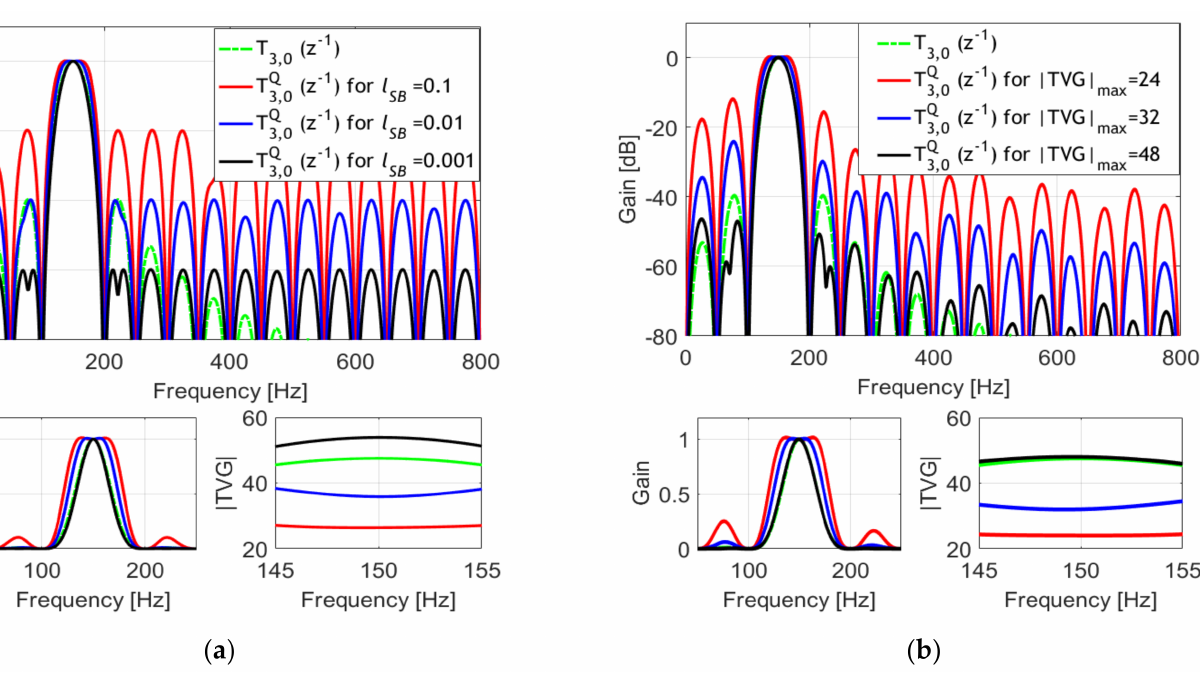
(cid:0) (cid:1) z − 1 ) transfer func- 3,0